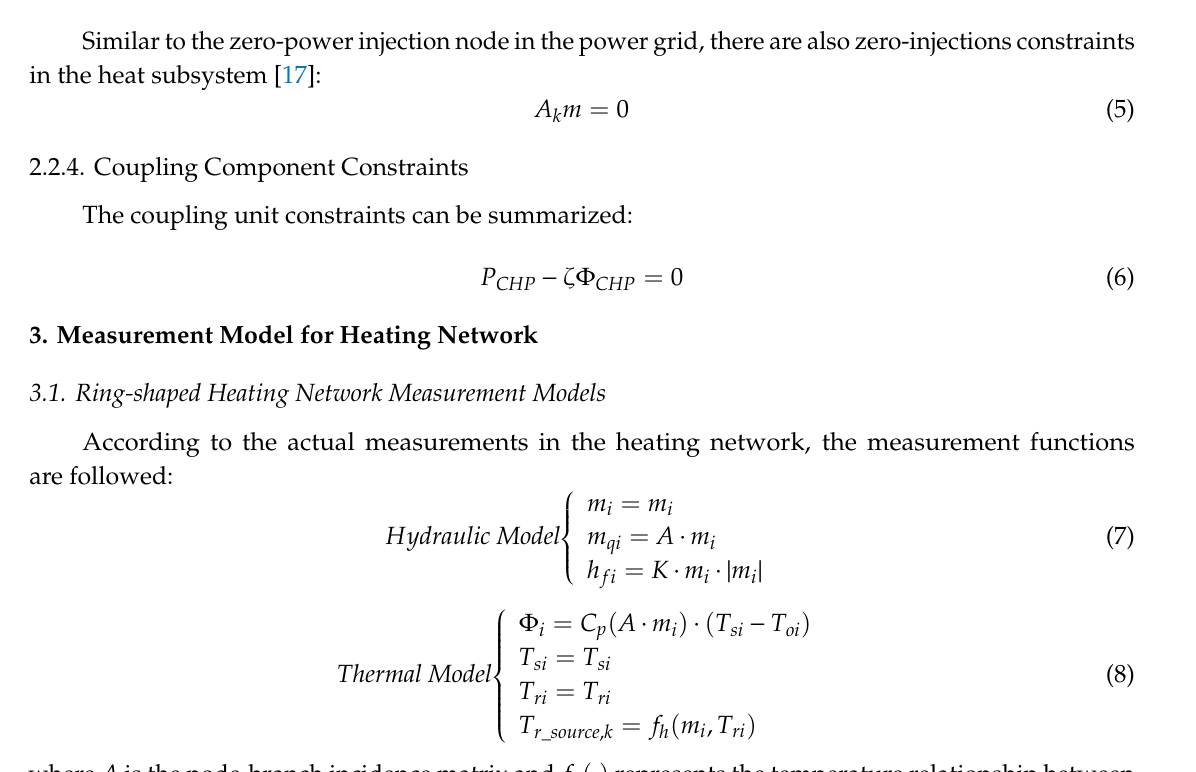
Figure 3. The schematic diagram of loop pressure